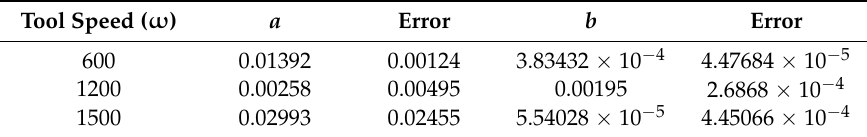
Table 2. Parameters of the reciprocal function.